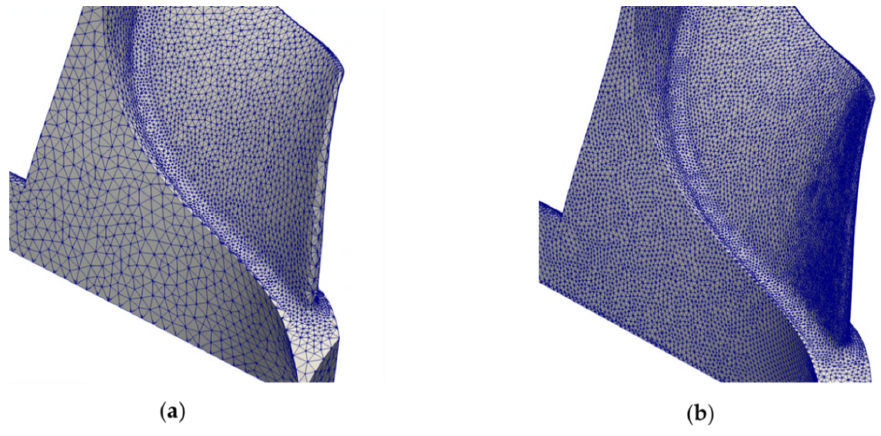
Figure 14. Comparison of solid mesh refinements: ( a ) coarse grid, ( b ) hybrid-mid grid.